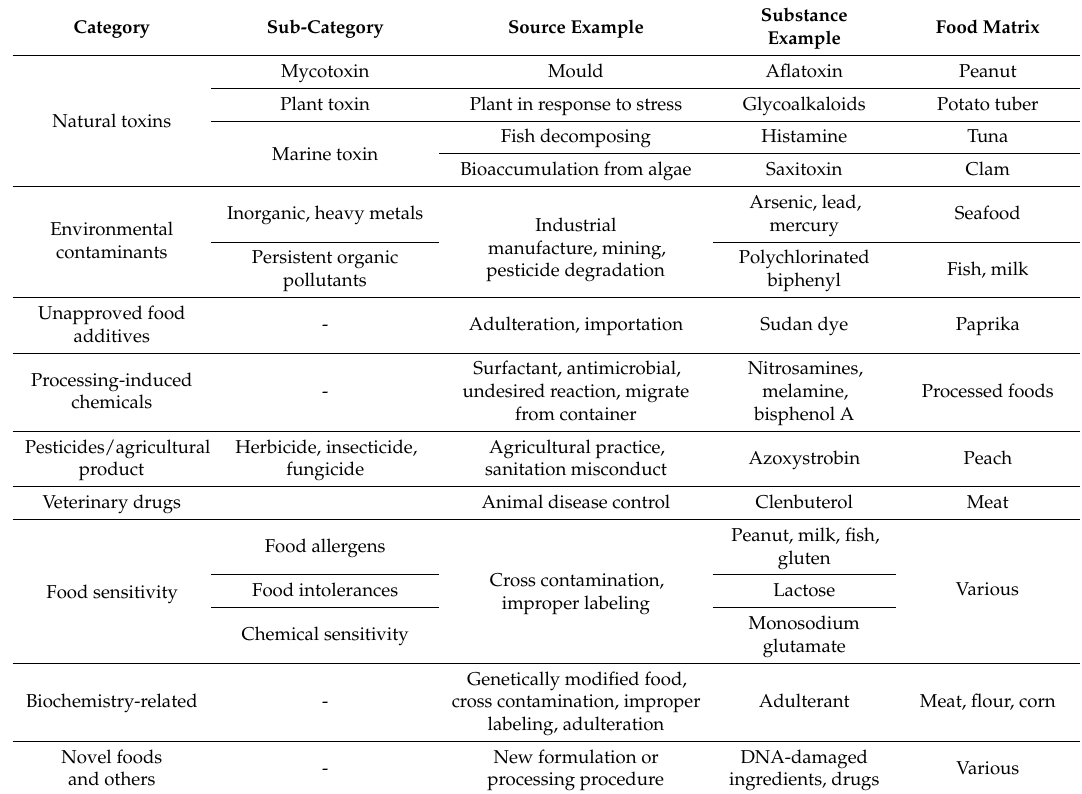
Table 1. Chemical hazards in food